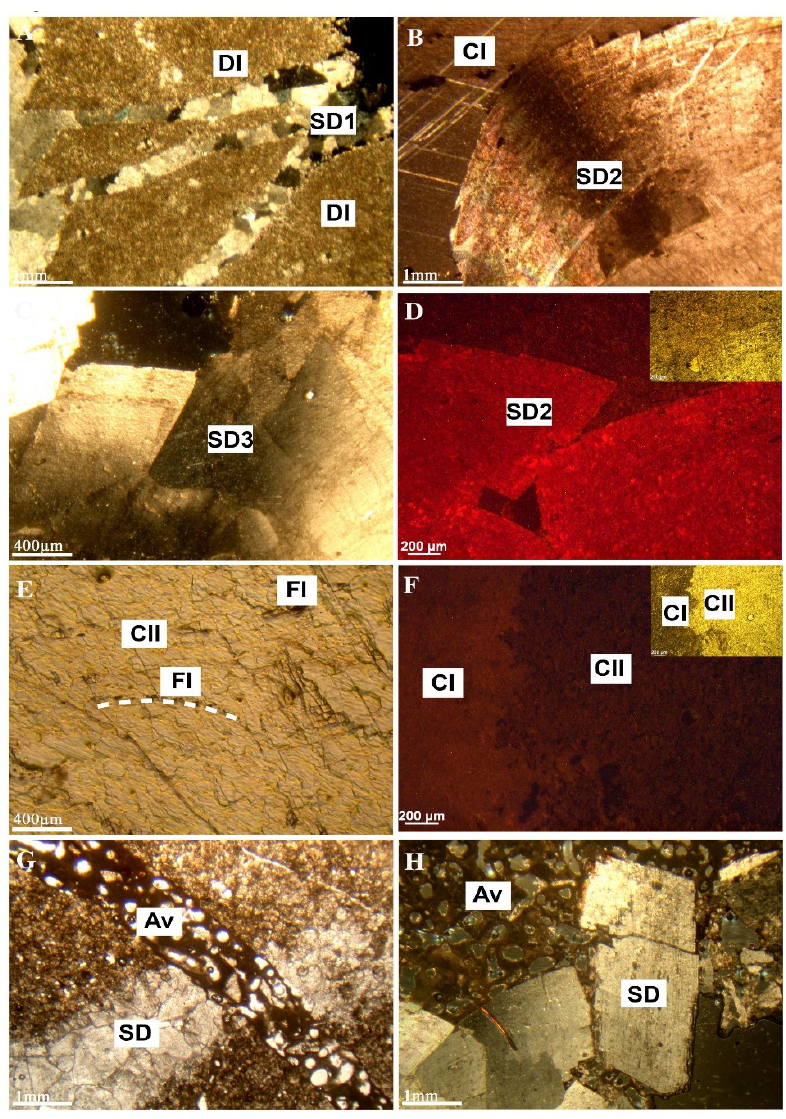
Figure 10. ( A – H ) Photomicrograph of hydrothermal saddle dolomites and calcites. ( A ) Thin section, polarized light, set of fractures filled by SD1, postdating the groundmass of DI. SD1 displays a unit extinction. Sulauk section. ( B ) Thin section, polarized light, typical wavy extinction and curved faces of saddle dolomite “SD2”, from rightmost part, with corroded borders of blocky calcite CI on the left side. Sulauk section. ( C ) Thin section, polarized light; typical saddle dolomite SD3 as SD1 (Figure 3B), with different transparent colors and zoned areas along the crystal surface. Sulauk section. ( D ) Thin section, under CL; saddle dolomite SD2 displays red with thin layers of bright luminescence along the boundary of the crystals, indicating that fluids precipitating DI, DII, and DIII differed from those which precipitated saddle dolomites. Spelek section. ( E ) Thin section, plane light, two set cleavages of transparent calcite CII in center of photo with alignment of fluid inclusions and one isolated fluid inclusion (FI) in the uppermost right part. Sulauk section. ( F ) Thin section, two types of calcites, CI in left part and CII in right part, with the strongly corroded boundaries of CI indicating that CI predated CII in the paragenetic sequence. Note the two different luminescences under CL light, suggesting different depositional setting conditions for